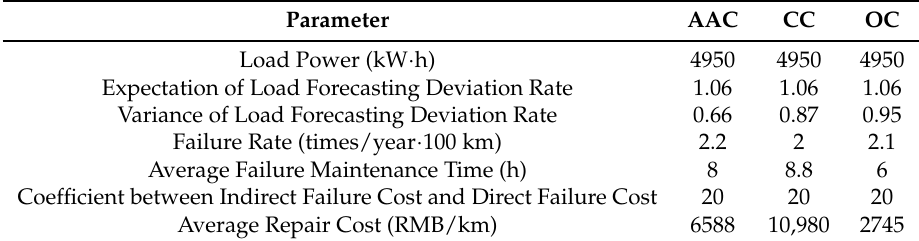
Table 9. Failure parameters in Case